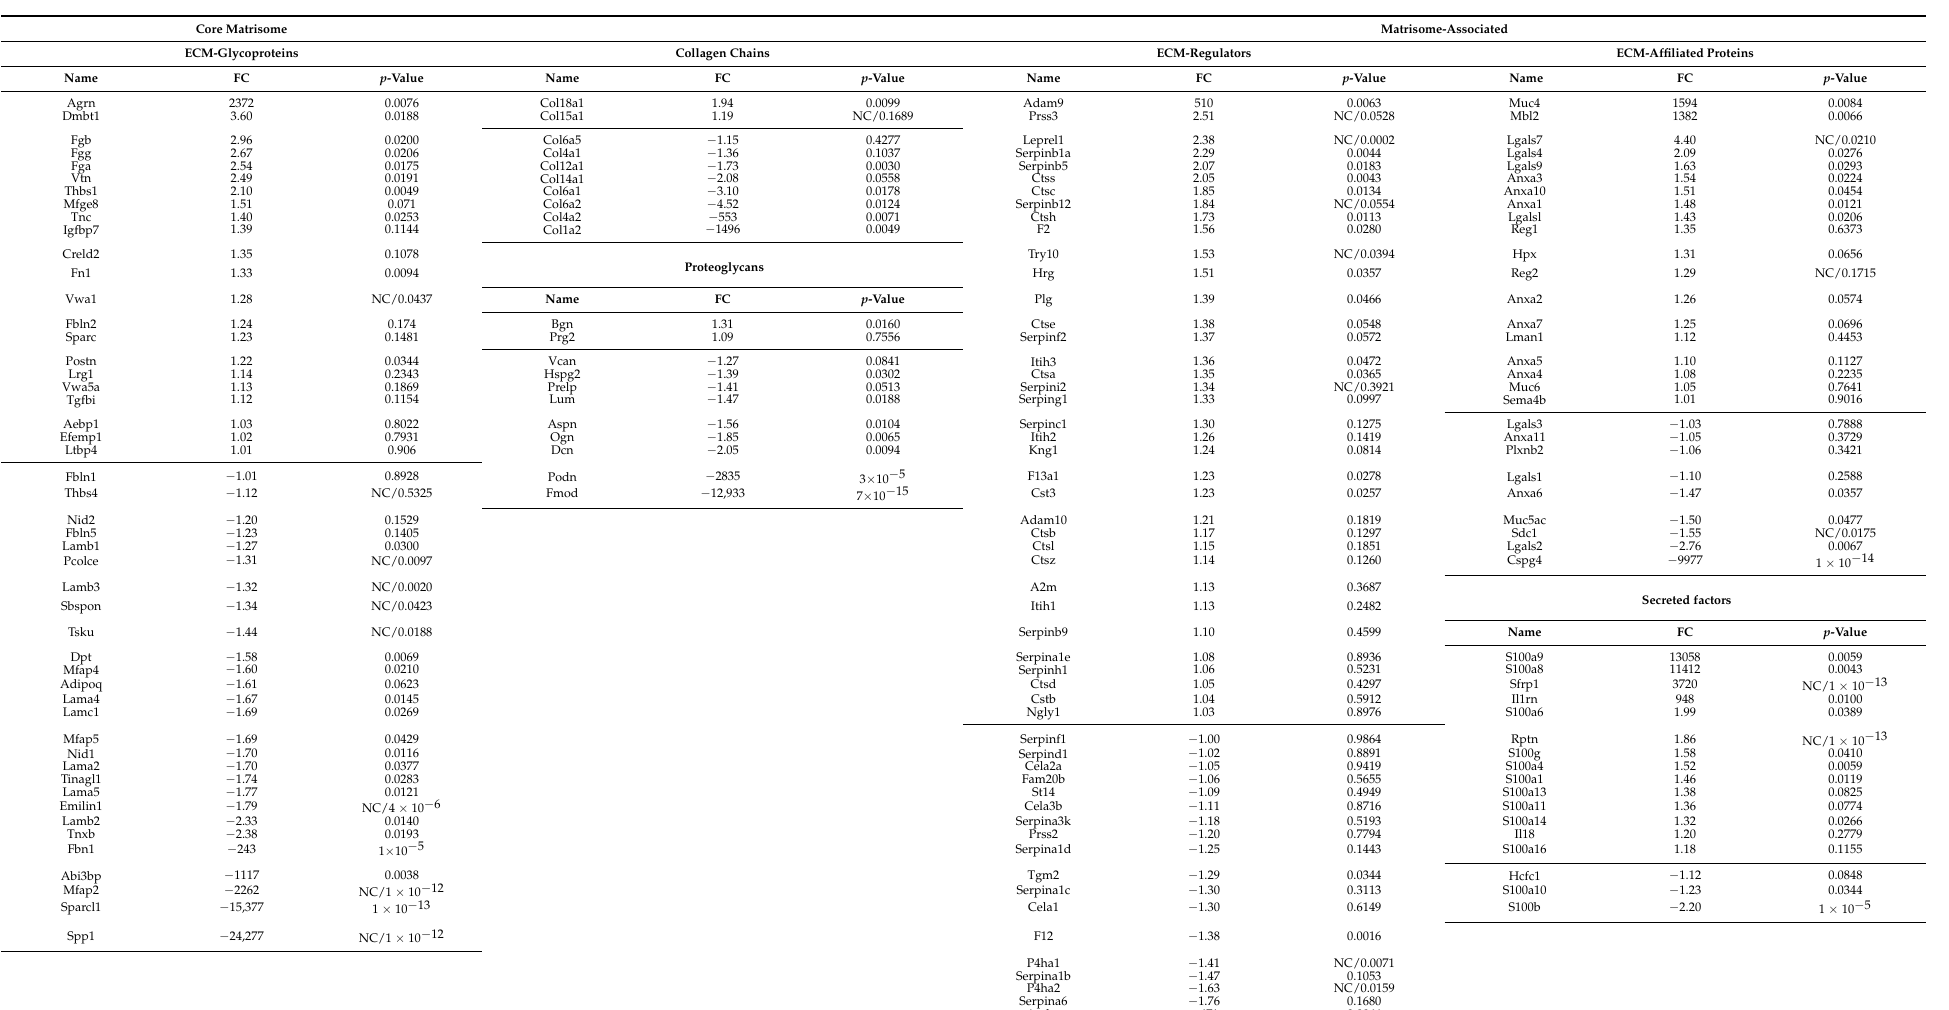
Table 1. Total antrum